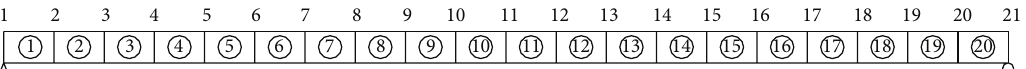
Figure 2: Model of simply supported bridge.